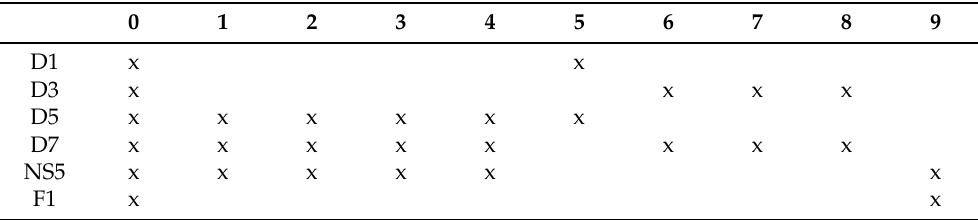
Table 5. Brane set-up underlying the geometry in (29) and (30). x 0 is the time direction, ( x 1 , . . . , x 4 ) span the CY 2 , x 5 is the direction associated with the ρ coordinate, ( x 6 , x 7 , x 8 ) are the transverse directions realising the SO(3) R-symmetry and x 9 is the ψ